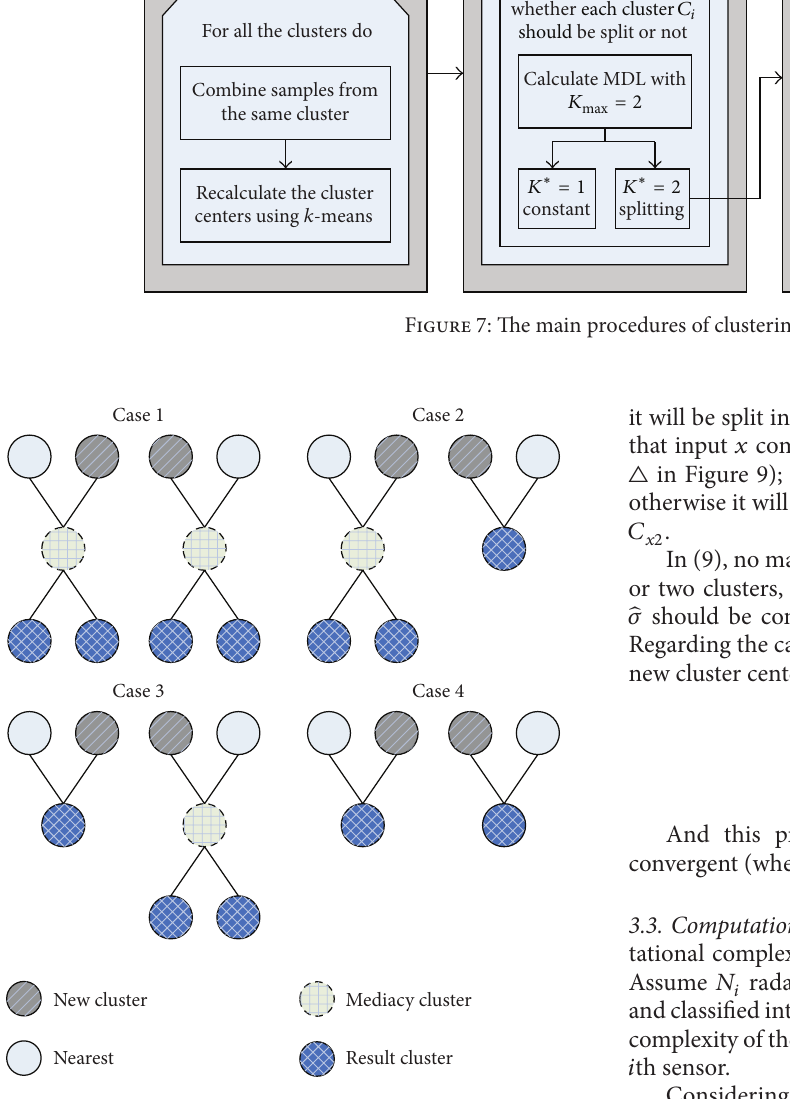
Figure 8: The procedure of regroup or